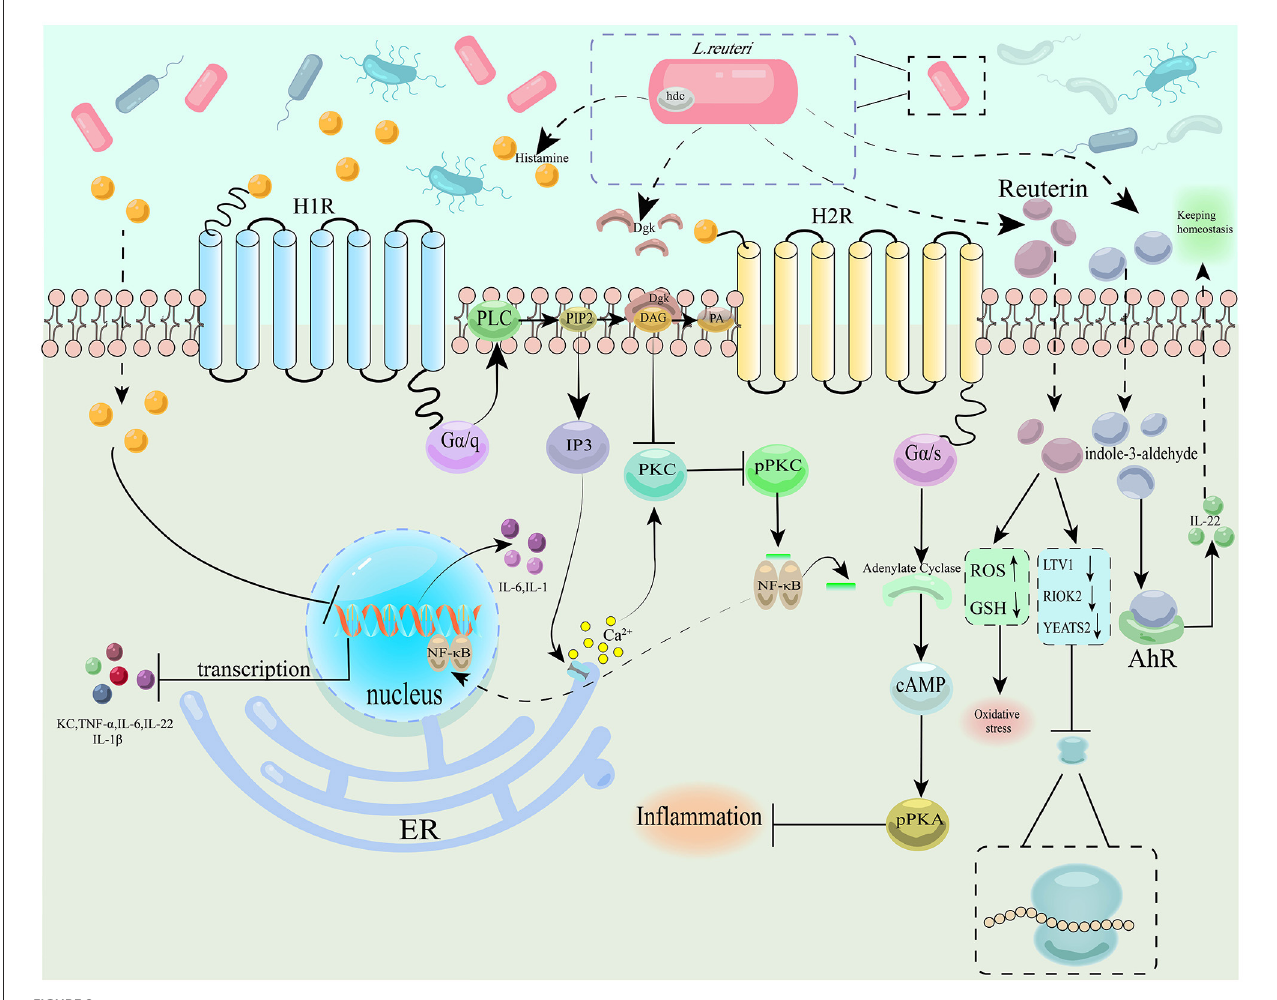
FIGURE2 Schematic diagram depicting the pathogenic role and therapeutic potential of Lactobacillus reuteri in CRC. H1R, type 1 histamine receptor; H2R, type 2 histamine receptor; hdc, histidine decarboxylase; PLC, phospholipase C; PIP2, phosphatidylinositol 2; Dgk, diacylglycerol kinase; DAG, diacylglycerol; PA, phosphatidic acid; IP3, inositol triphosphate; PKC, protein kinase C; pPKC, phosphorylated protein kinase C; ER, endoplasmic reticulum; AhR, aryl hydrocarbon receptor; PKA, protein kinase A; pPKA, phosphorylated protein kinase A; KC, keratinocyte chemoattractant; ROS, reactive oxygen species; GSH, glutathione; LTV1, LTV1 ribosome biogenesis factor; RIOK2, right open reading frame kinase 2; YEATS2, YEATS domain-containing protein